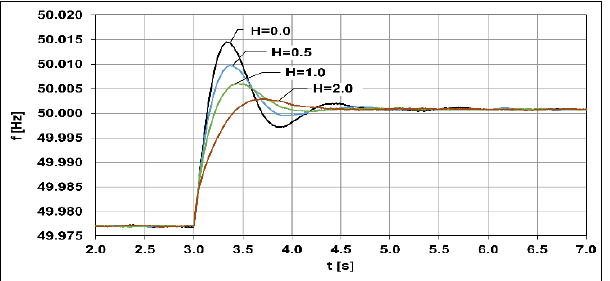
Figure 13. Frequency changes during load reduction for selected inertia coefficients.